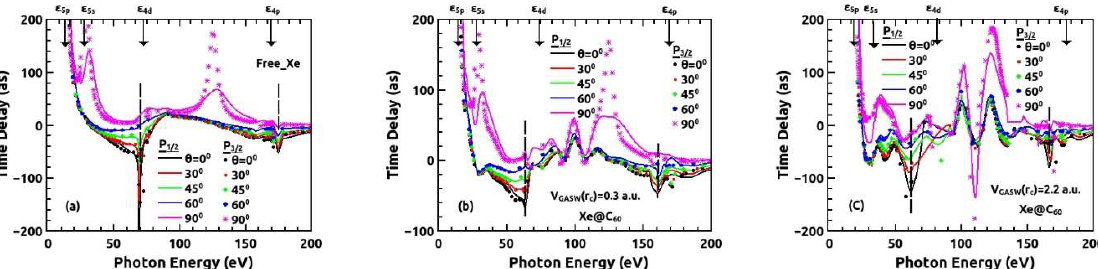
Figure 16. Spin average, angle-dependent time delay of photoionization from the 5p subshell of ( a ) free and confined Xe using the depths of ( b ) 0.3 a.u. ( middle panel ) and ( c ) 2.2 a.u. ( right panel ). Vertical lines denote the location of Cooper minima. Vertical arrows indicate the threshold values of the corresponding subshells used in the